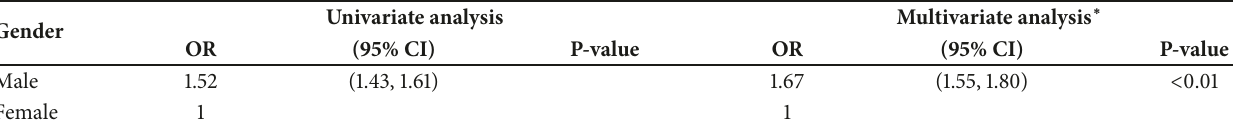
Table 3: Univariate and multivariate analysis of the association between gender and approval status.